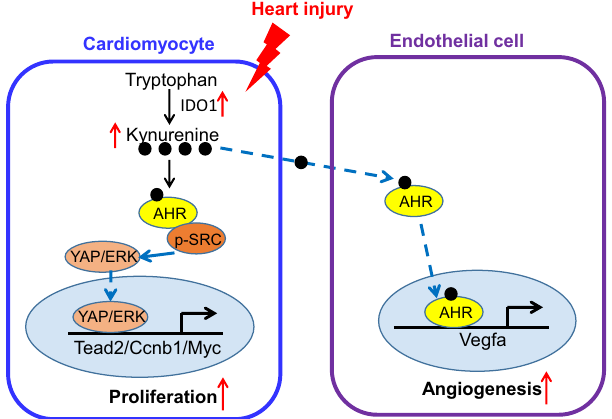
Fig. 7 | Kynurenine promotes cardiac regeneration by activating cardiomyo- cyte proliferation and endothelial angiogenesis. Rapid elevation of IDO1 cata- lyzestheconversionoftryptophantoKyninneonatalandadultheartregeneration models. The accumulated Kyn binds to AhR and triggers the cardiac cytoplasm SRC-YAP/ERK pathway to activate CM proliferation. On the other hand, the accu- mulated Kyn transports to endothelial cells and binds to AHR, which resulting in translocation to the nucleus, transcriptional upregulation of VEGFA, and promo- tion the cardiac